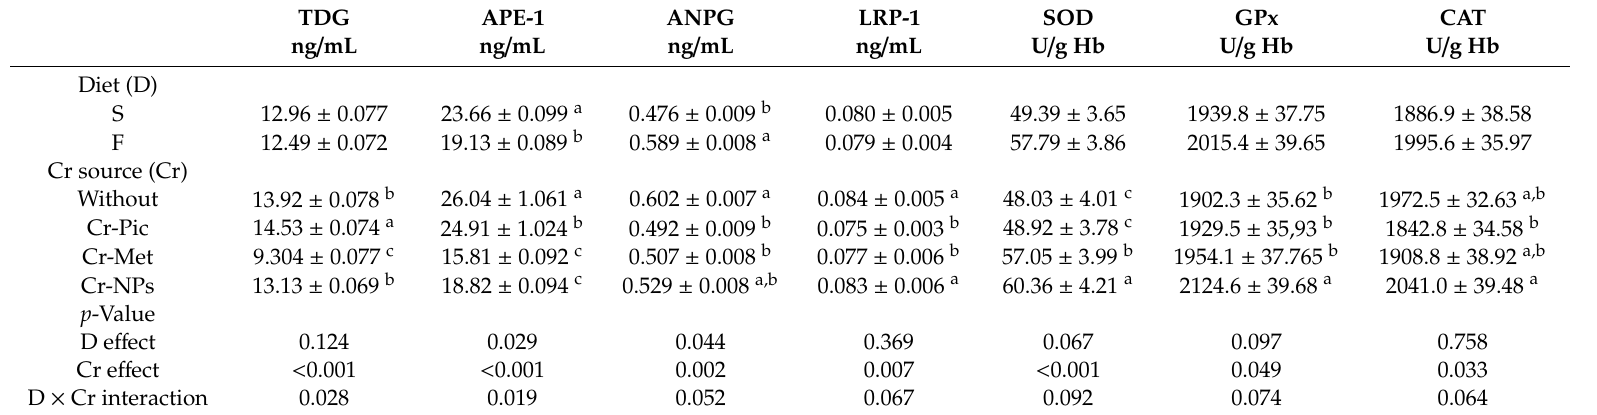
Table 4. Activity of DNA repair and antioxidant enzymes in rat